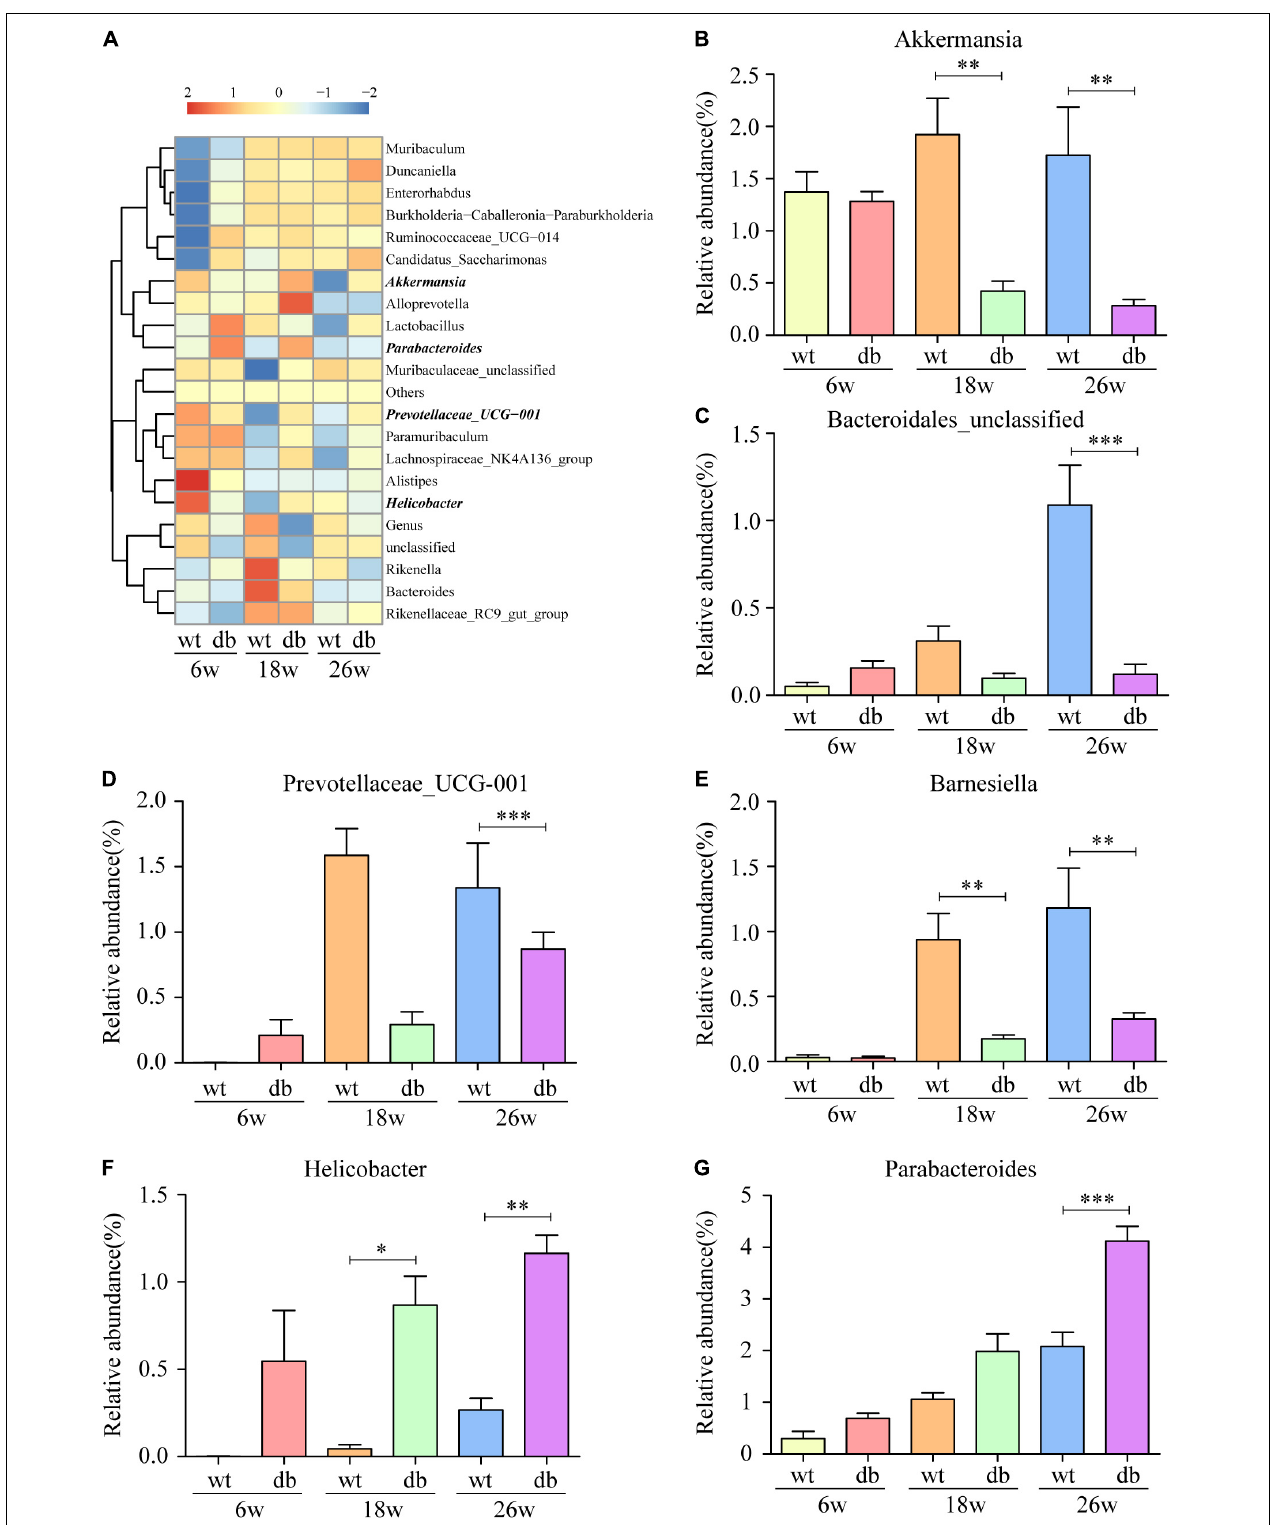
FIGURE 7 | Alteration of gut microbiota composition in db/db mice at the genus level. (A) Community heatmap at the genus level. (B–G) The relative abundance of six bacterial communities in each group. ( n = 6 per group); ∗ P < 0.05; ∗∗ P < 0.01; ∗∗∗ P < 0.001.